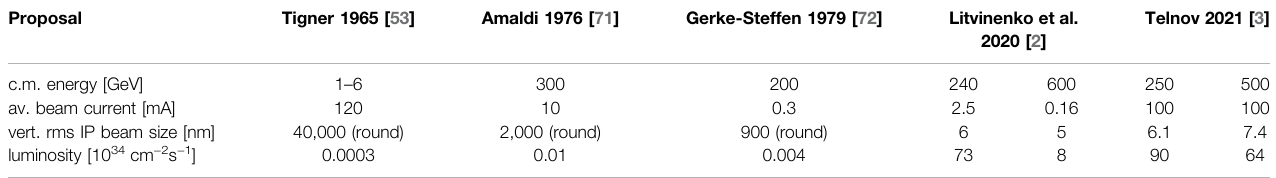
TABLE 2 | A comparison of ERL-based colliders proposed in the 1960s [53] and 1970s [71,72], and in the recent period 2019 – 2021 [3,2].